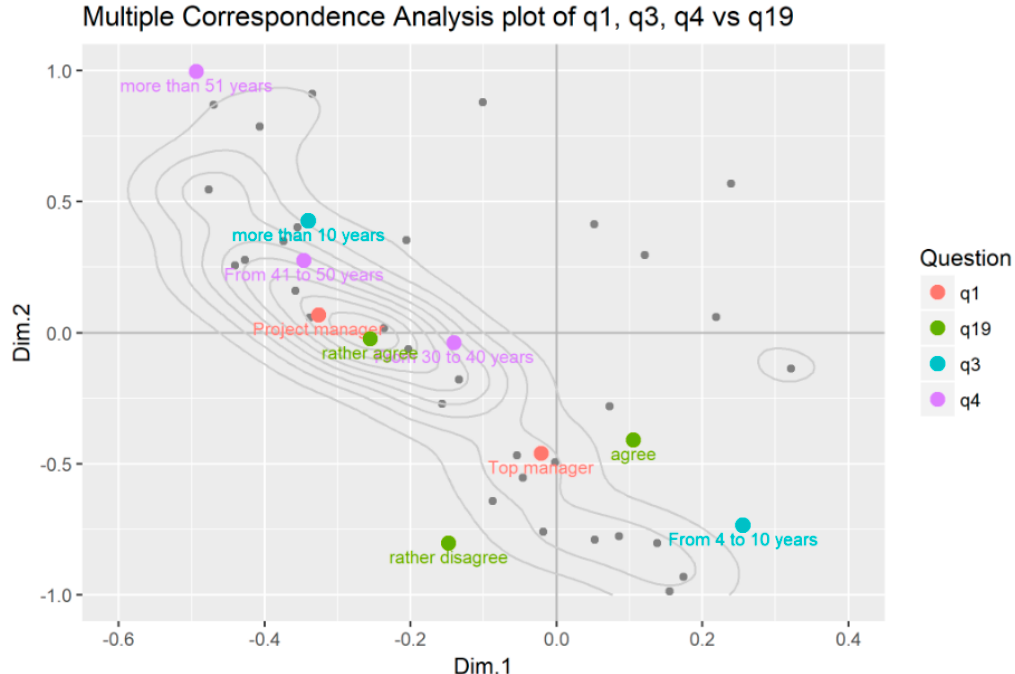
Figure 3. Answers to the question: I am willing to work with the university to teach.